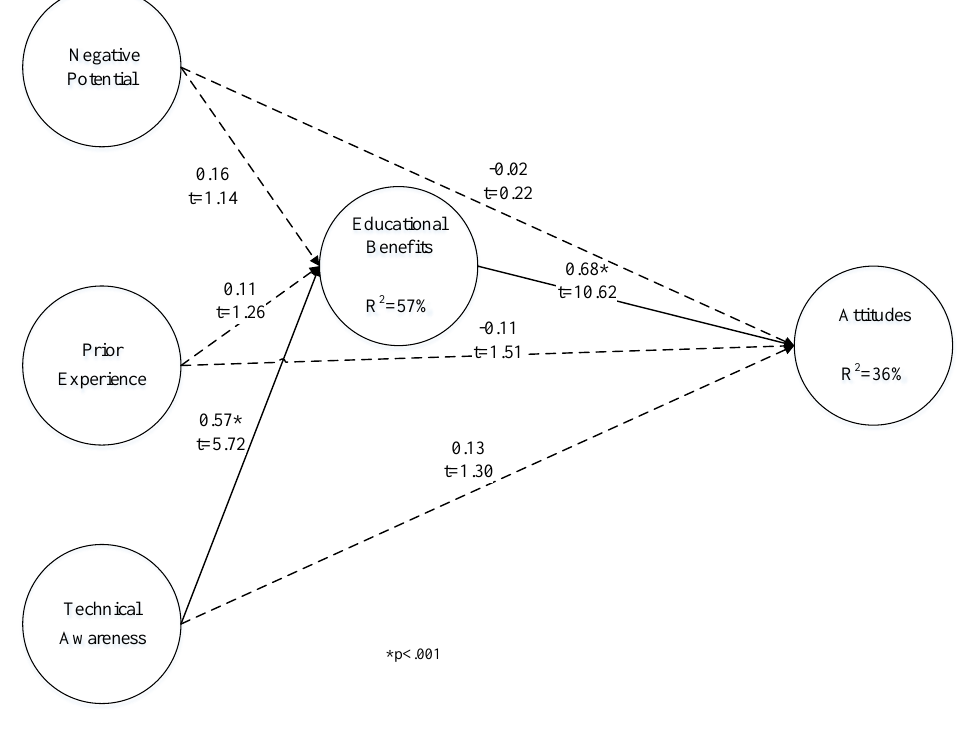
Figure 4. Results of structural model test for parents.